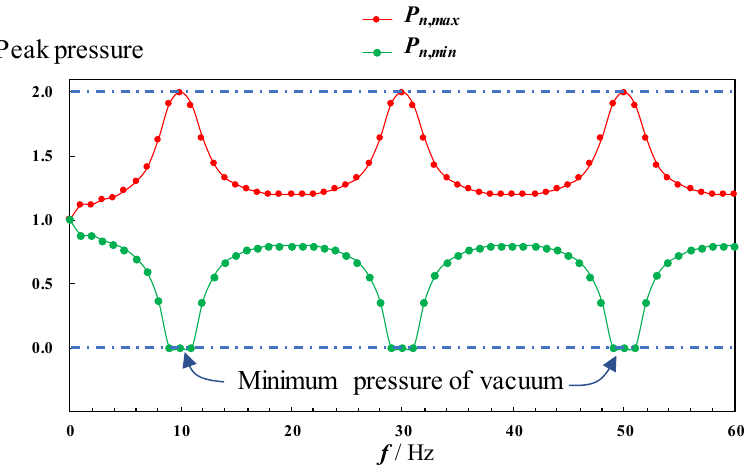
Figure 7. Relationship between the normalized peak pressure P n , max , P n , min and frequency f at endpoint where L x = 25 m.